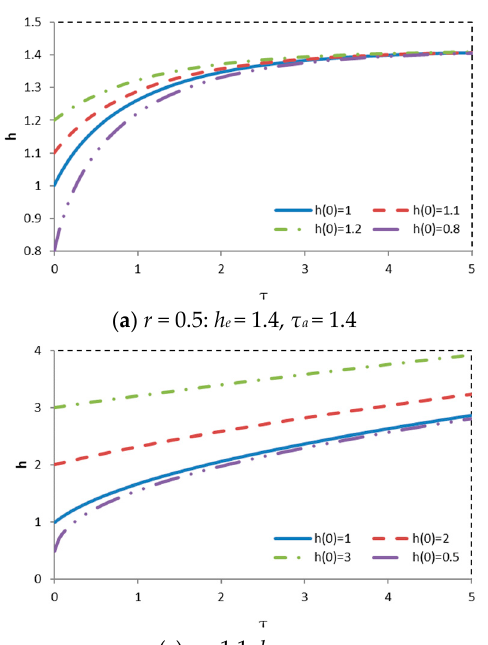
Figure 5. Transient development for various sea-level rise (SLR) rates starting from equilibrium state